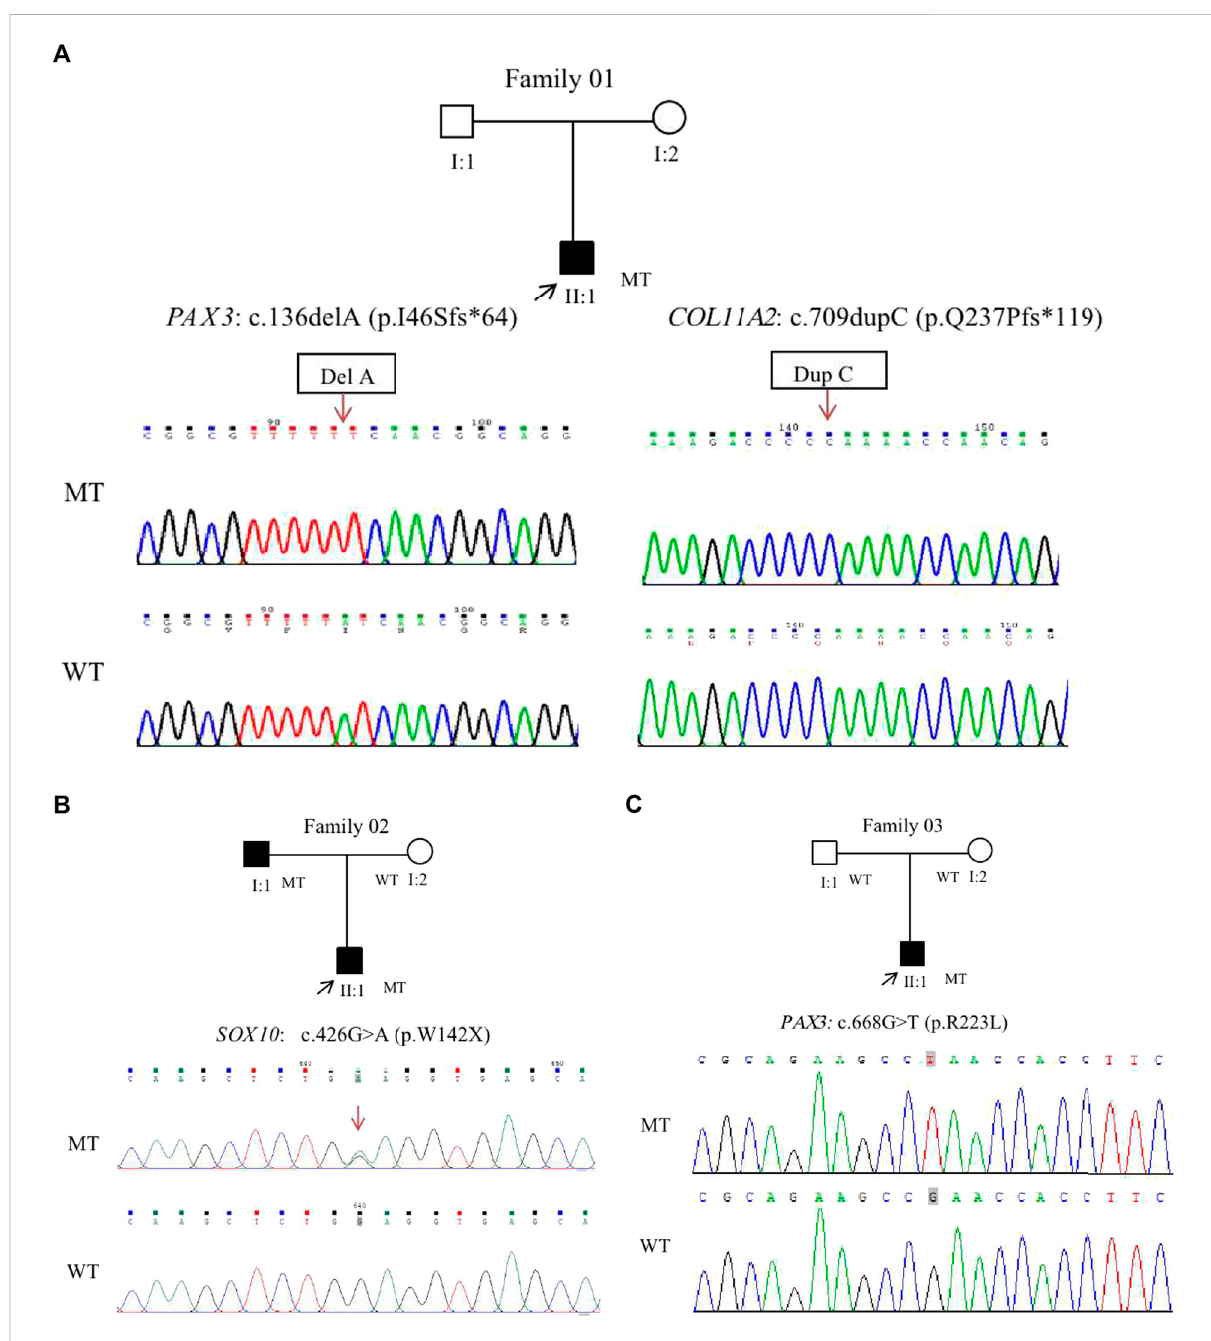
FIGURE 3 Four novel variants wereidenti fi edfrom threeWS patients inthisstudy. A doublegene variant inthe PAX3 and COL11A2 was detected inPatient 01. Cloning sequencing showed that a single nucleotide deletion of c.136del A was detected in the PAX3 , and a single nucleotide duplication of c.709dupC was found in the COL11A2 gene (A) . A heterozygote missense variation of c.426G > A in SOX10 was detected in the Patient 02 (B) . This variant resulted in an amino acid of Tryptophan (W) at Codon 142 replaced by a premature terminate codon. A novel heterozygote missense variation of c.668G > Tin PAX3 was detected in Patient 03 (C) . The variant led to an amino acid of Arginine atCodon 223 replaced by Leucine. Mutant type (upper row), wide type (lower row); the arrows denote the locations of the indel